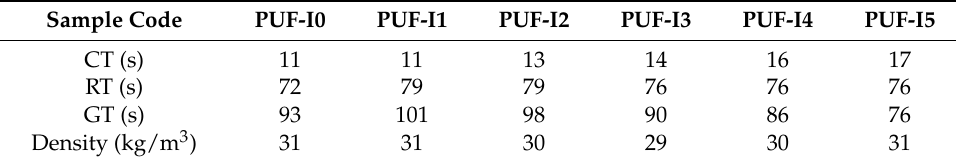
Table 2. Characteristics of FPUFs with differing amounts of